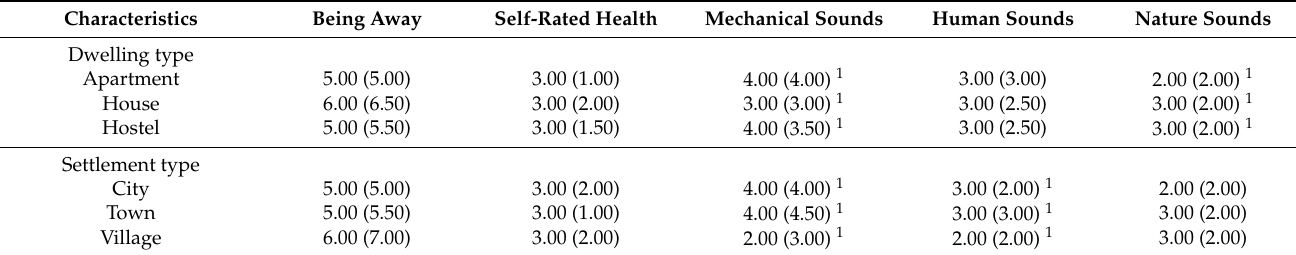
Table 4. Associations between multicategorical participant characteristics and self-rated health, being away, and per- ceived sounds.